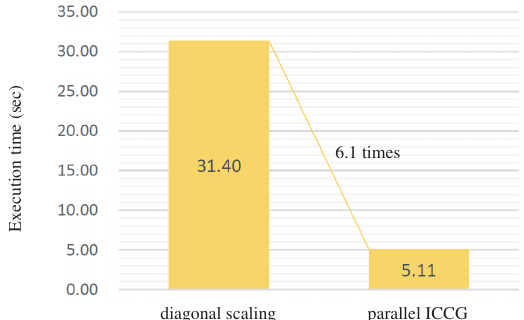
Figure 17. Execution time for the 51 × 51 × 52 mesh.